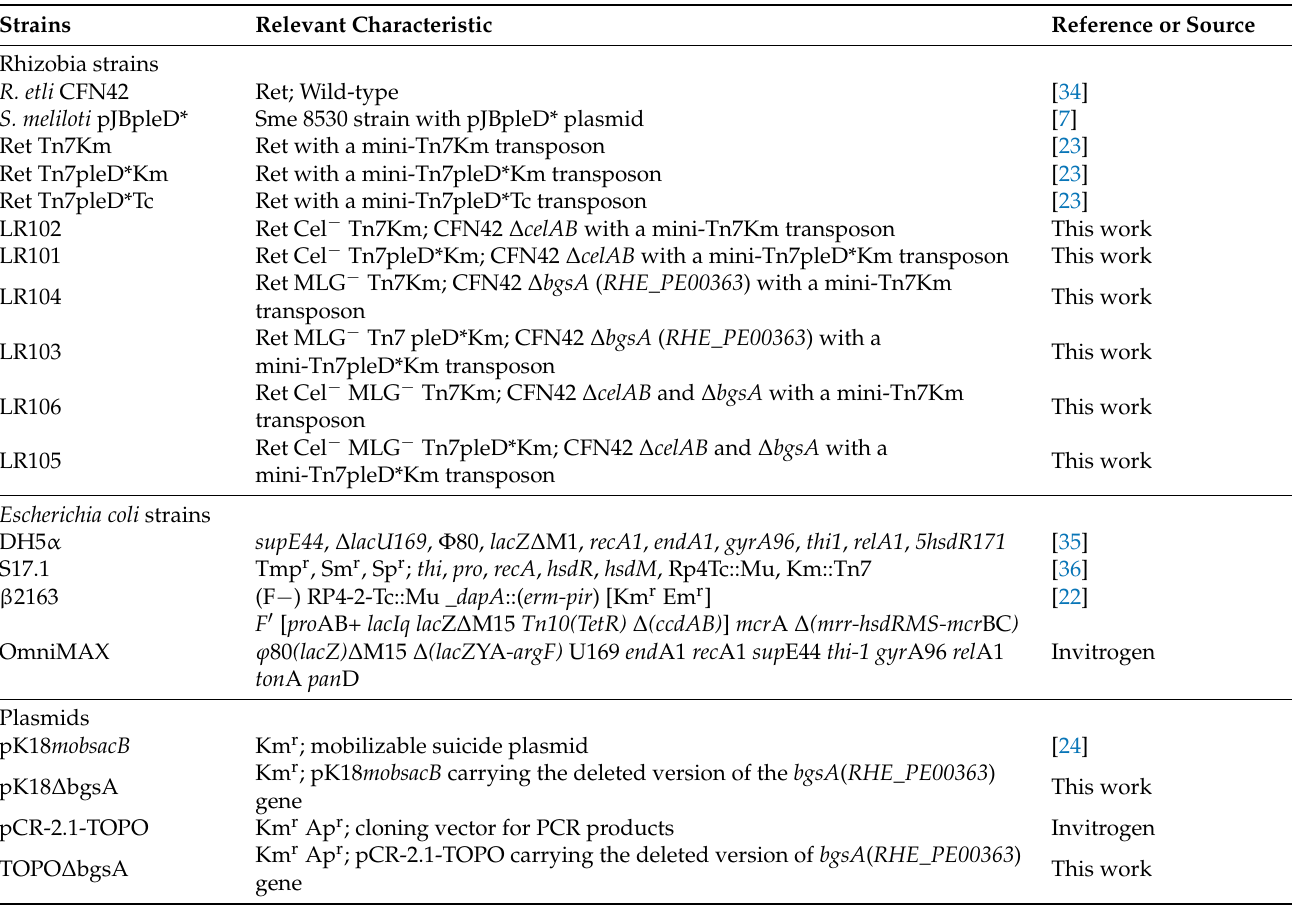
Table 1. Bacterial strains and plasmids used in this